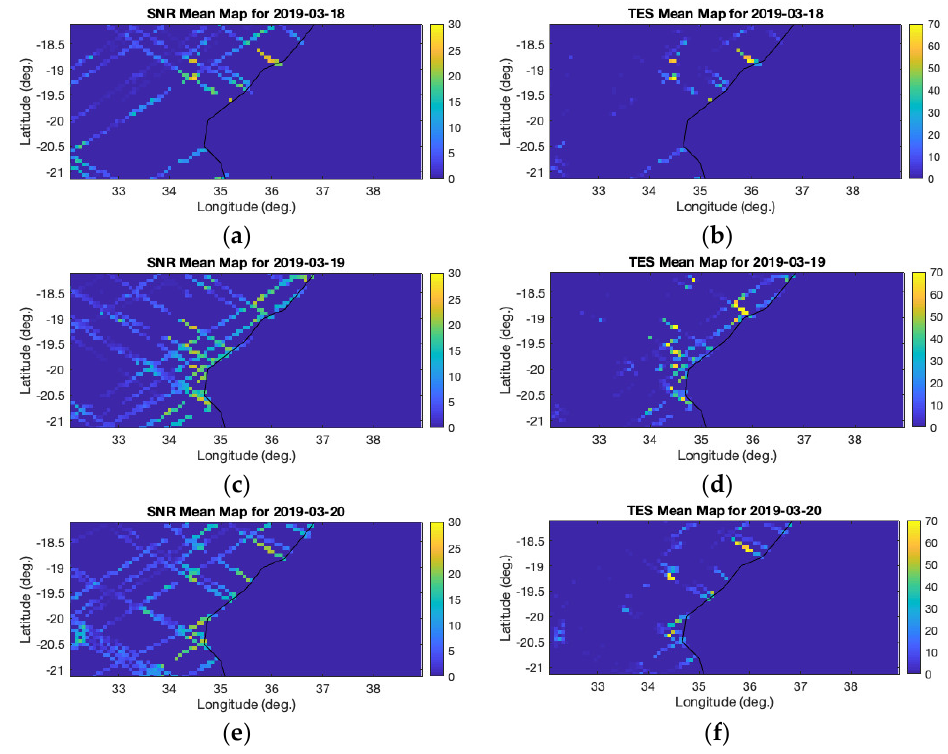
Figure 6. Daily means obtained from CYGNSS data for SNR observable (left column: ( a , c , e )) and for TES observable (right column: ( b , d , f )), for days: 18 March 2019 ( a , b ), 19 March 2019 ( c , d ), and 20 March 2019 ( e , f ).